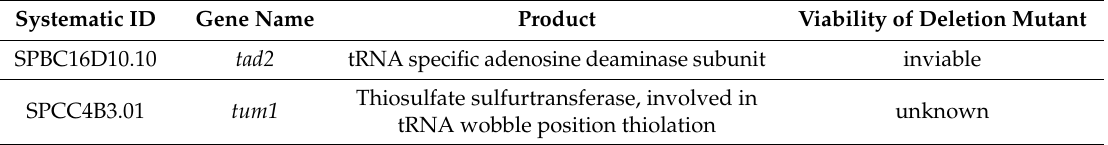
Table 3. tRNA-related S. pombe genes downregulated more than three-fold after treatment with rapamycin and ca ff Table 2. tRNA-related S. pombe genes upregulated more than three-fold after treatment with rapamycin and caffeine.